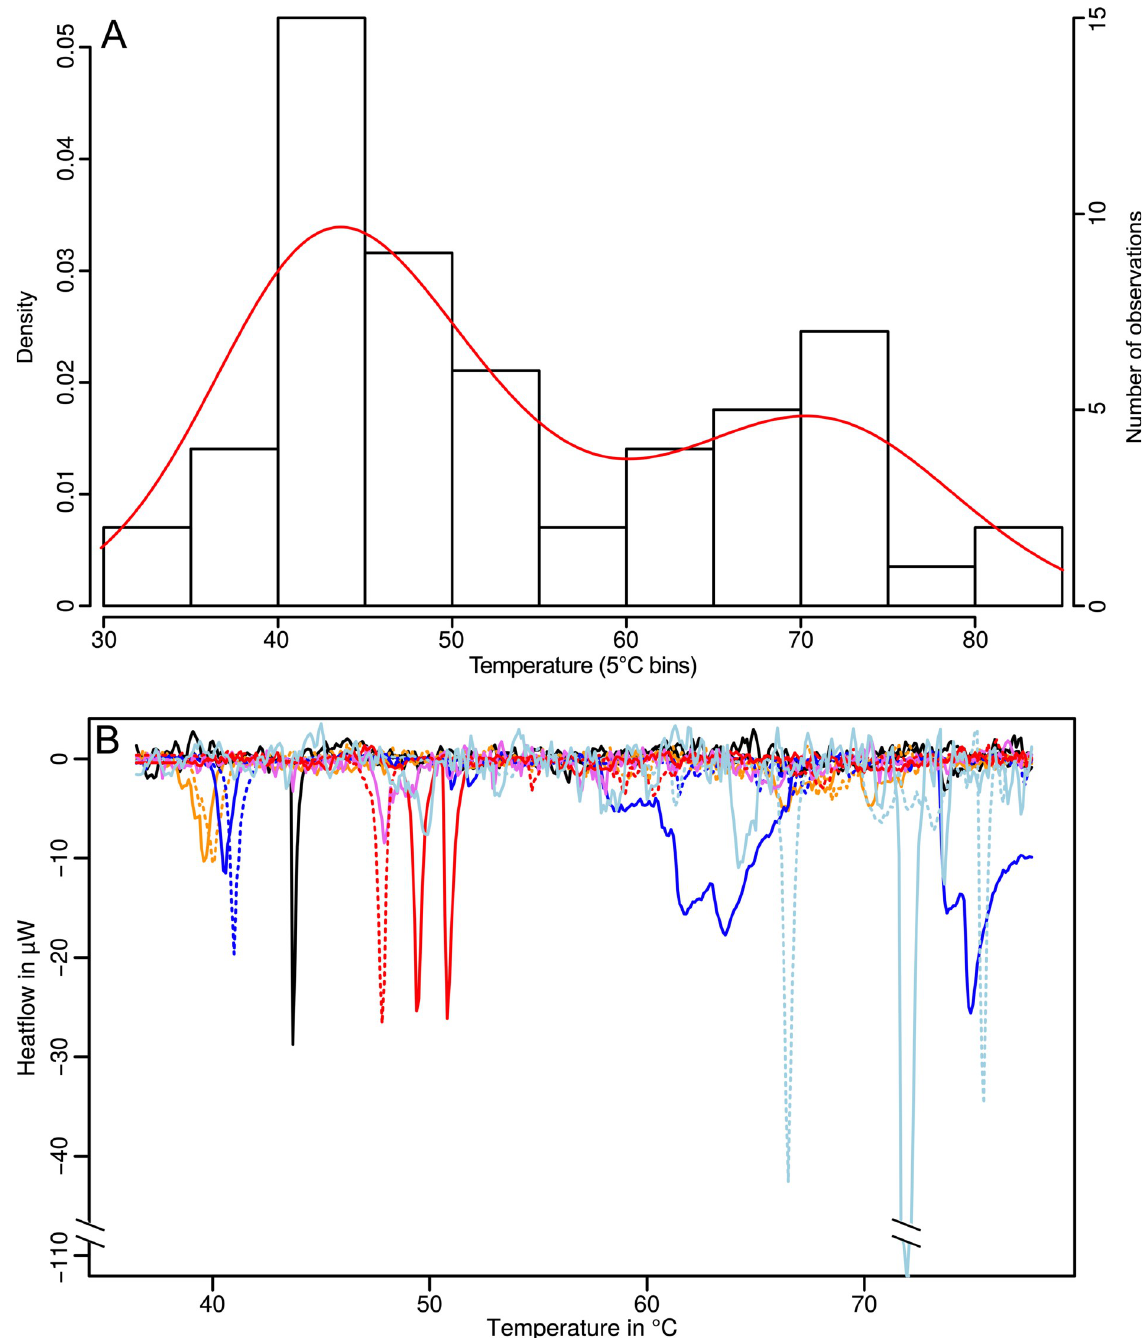
Fig 1. Distribution of proteins by denaturation temperature. (A) Peak distribution in saliva samples in 5˚C intervals for all healthy volunteers tested; (B) DSC pattern from the same healthy volunteer taken different days (colour refers to the sample collected at the same time; dashed and solid lines show the replicates for a sample collected and treated the same